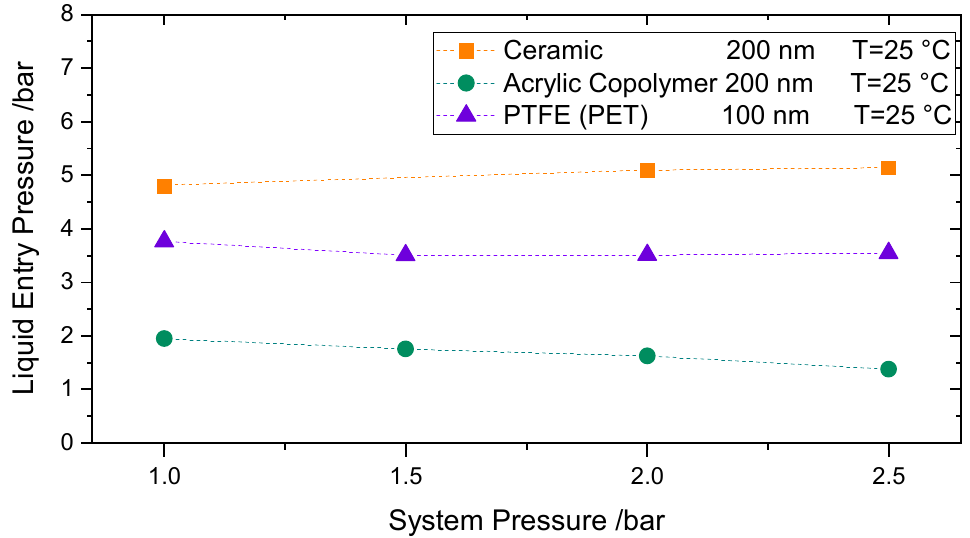
Figure 9. Influence of system pressures up to 2.5 bar abs on Liquid Entry Pressure for an Acrylic Copolymeric Membrane 200 nm (Green), Ceramic Membrane 200 nm (Orange), and a PTFE (PET) membrane 100 nm (100).